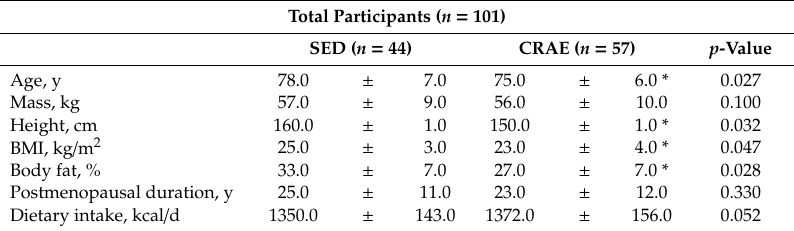
Values are Mean ± SD. SED: sedentary control group, CRAE: combined resistance and aerobic exercise training group. BMI: body mass index. Values are Mean ± SD. * p < 0.05 vs.